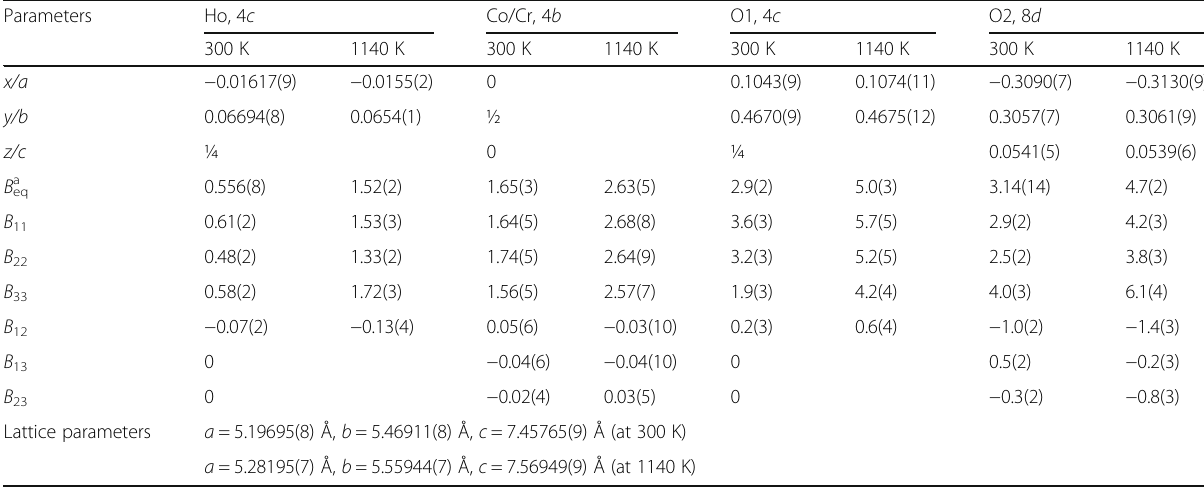
B a *) 2 a 2 + … 2 B a B iso/eq =1/3[ 11 (